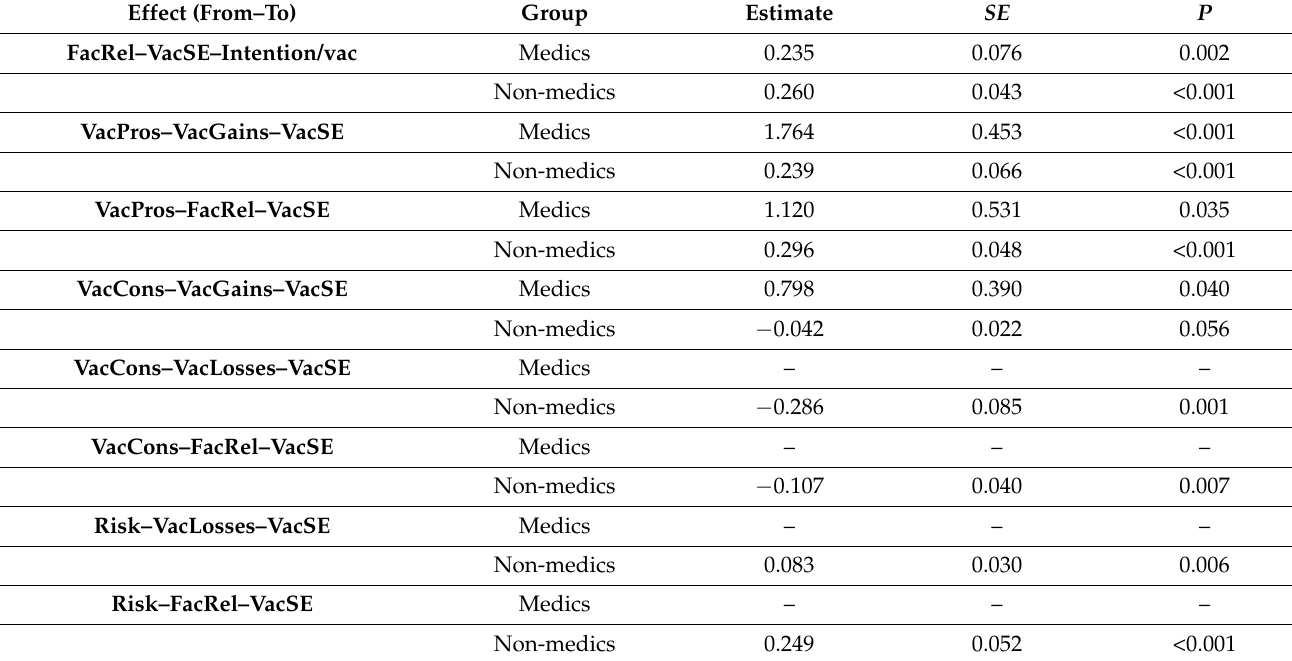
Table 3. Specific indirect effects between predictors in medics and non-medics (only